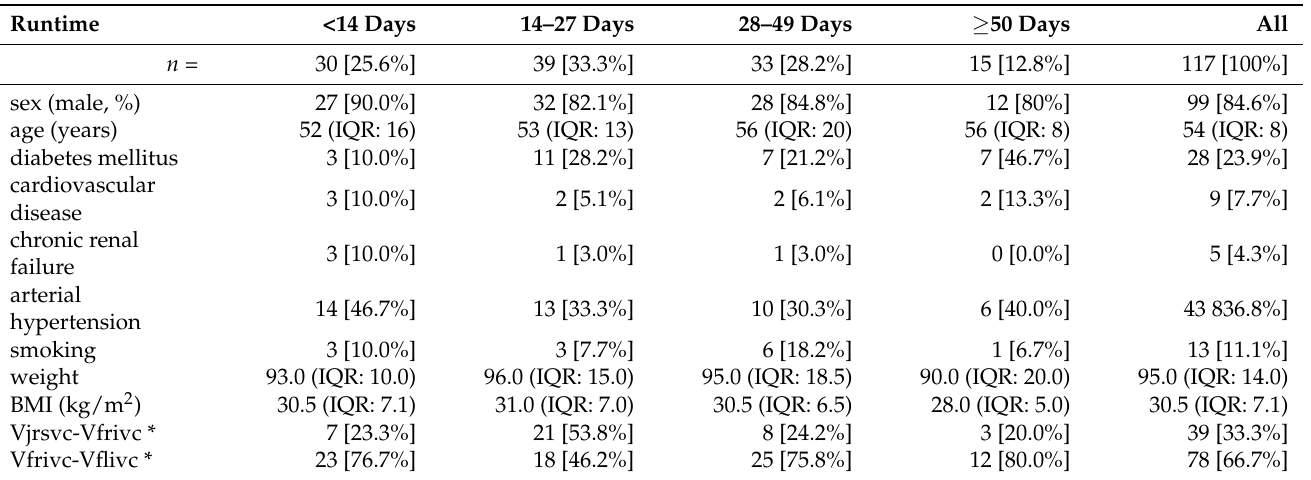
Table 1. Clinical characteristics.